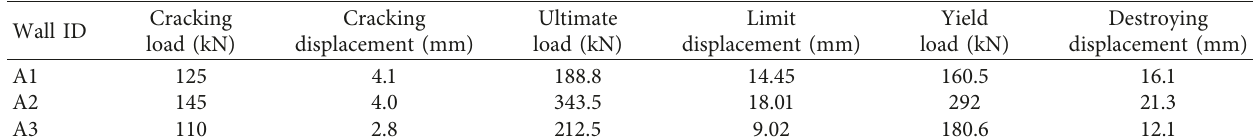
T ABLE 3: Characteristics of the load and displacement response of the